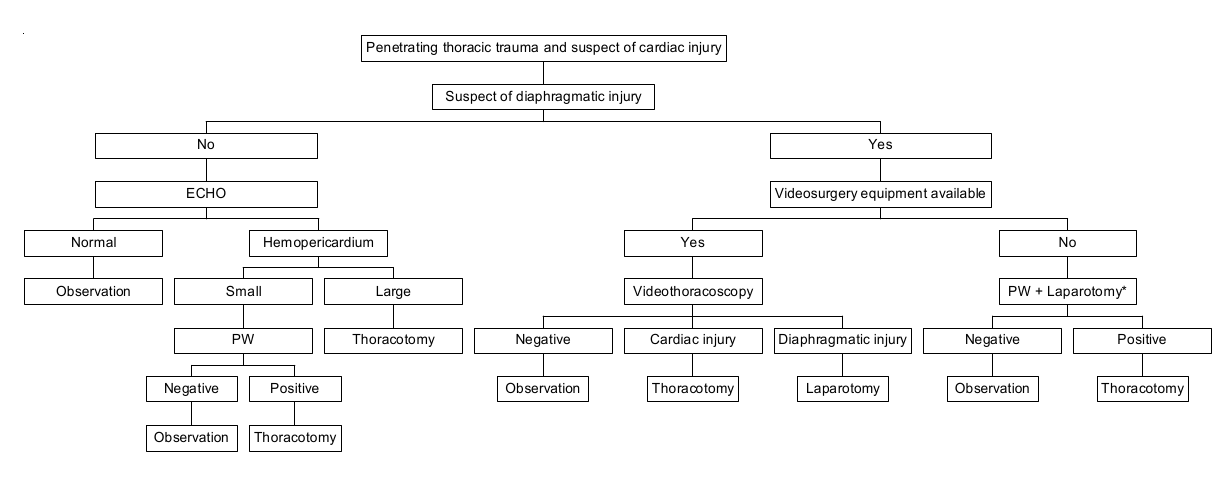
FIGURE 1 - Sequence of diagnostic investigation methods in hemodynamic stable patients with suspect of cardiac